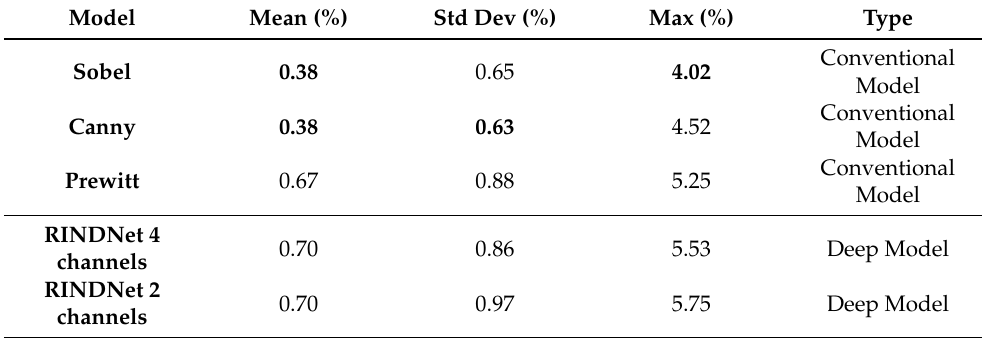
Table 3. Percentage of the mean, standard deviation and maximum error distance measured in pixels and standardized by the image diagonal. Results are for 5-fold-cross-validation on the mix dataset. Best results are highlighted in